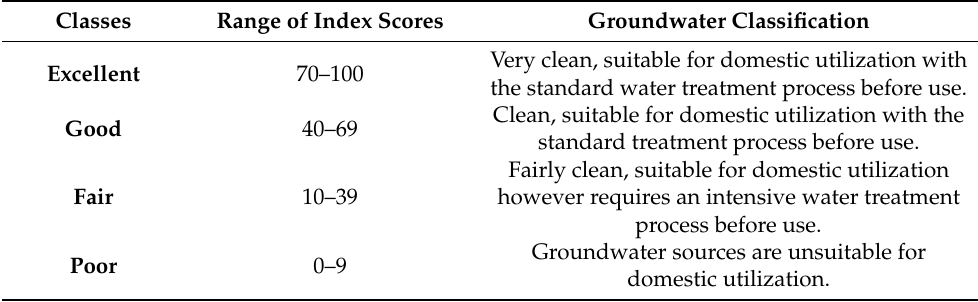
Table 14. Groundwater description for each groundwater